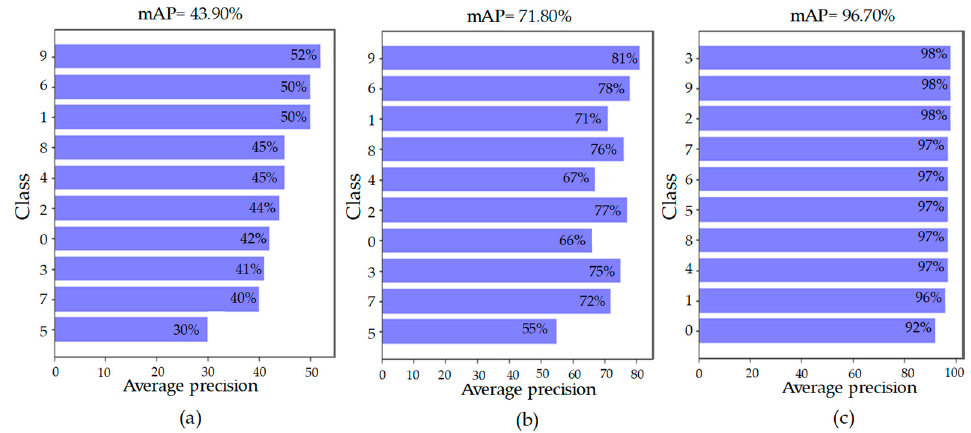
Figure 16. mAP comparison results for only numbers (0–9). ( a ), ( b ), ( c ) represent the mAP results on bicubic results (3×), proposed SR results (3×), and HR images, respectively. bicubic results (3 × ), proposed SR results (3 × ), and HR images,